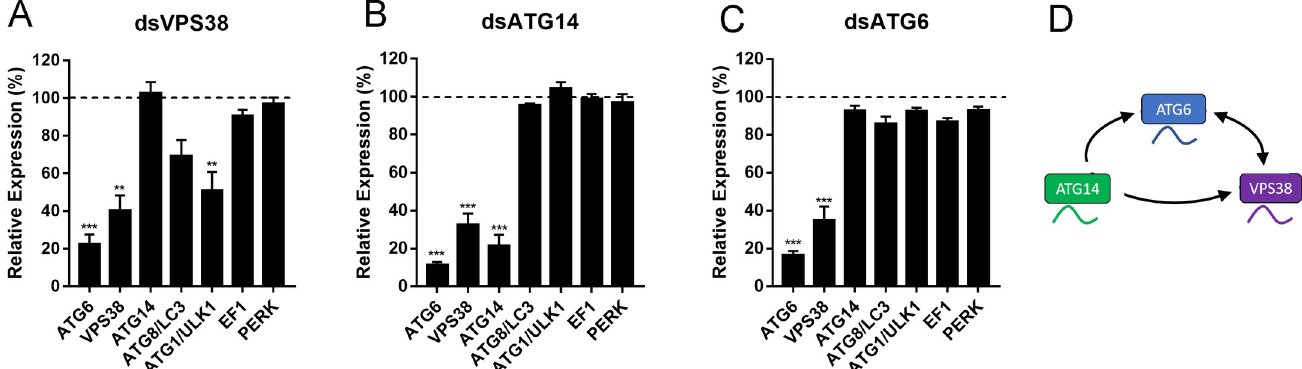
Fig 6. VPS38/UVRAG, ATG14 and ATG6/Beclin1 are transcriptionally regulated in the oocytes of Rhodnius prolixus . Oocytes dissected from silenced females were tested for the expression levels of the other class III PI3K components, and for the control genes ATG8/LC3, ATG1/ULK1, EF1 and PERK (non-related to the class III PI3K complexes). A. Expression levels of different genes in the ovaries of females silenced for VPS38/UVRAG (dsVPS38). B. Expression levels of different genes in the ovaries of females silenced for ATG14 (dsATG14). C. Expression levels of different genes in the ovaries of females silenced for ATG6/Beclin1 (dsATG6/ Beclin1). Graphs show mean ± SEM. (n = 8) �� p < 0.01, ��� p < 0.001. One Way ANOVA. D. Model for the transcriptional regulations between ATG6/Beclin1, VPS38/UVRAG and